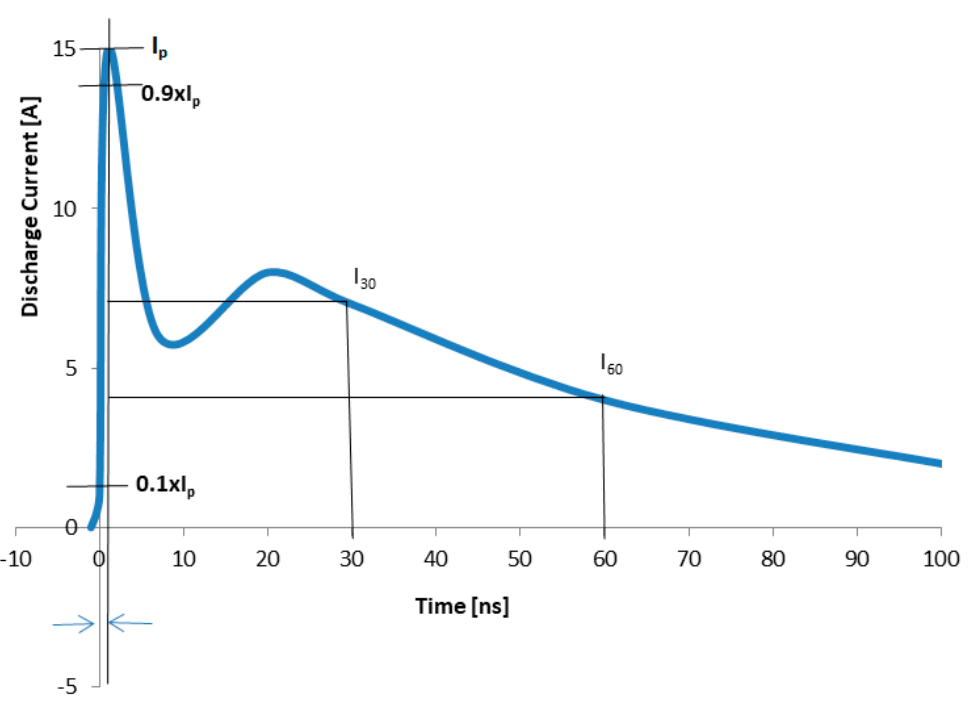
Figure 1. Typical waveform of the output current of the ESD gun for contact discharges.